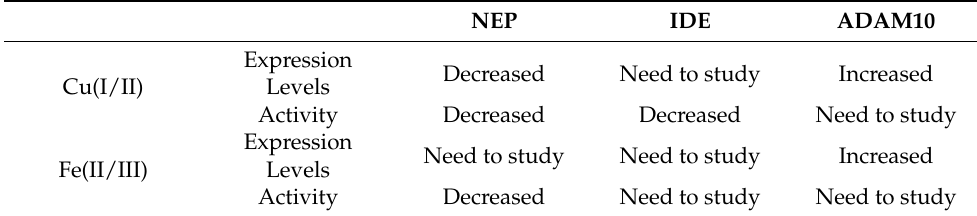
Table 4. The reported relations between redox-active metal ions and ADE. The changes in expression levels and/or activity of NEP, IDE, and ADAM10 associated with Cu(I/II) and Fe(II/III). NEP IDE ADAM10 Expression Decreased Need to study Increased Levels Cu(I/II) Activity Decreased Decreased Need to study Expression Need to study Need to study Increased Levels Fe(II/III) Activity Decreased Need to study Need to